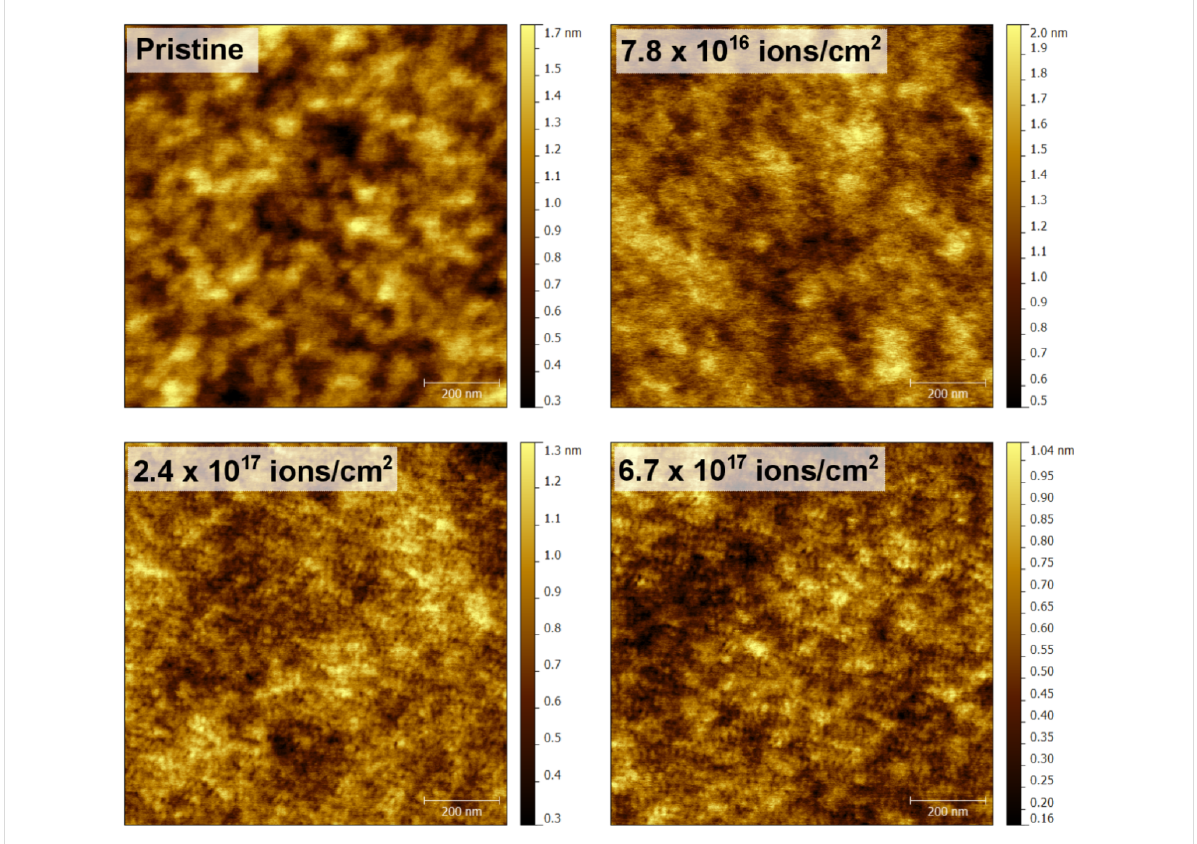
Figure 1: Changing topography of PMMA bombarded by 5.5 keV Ne + as a function of fluence (FOV: 1 × 1 µm 2 ).